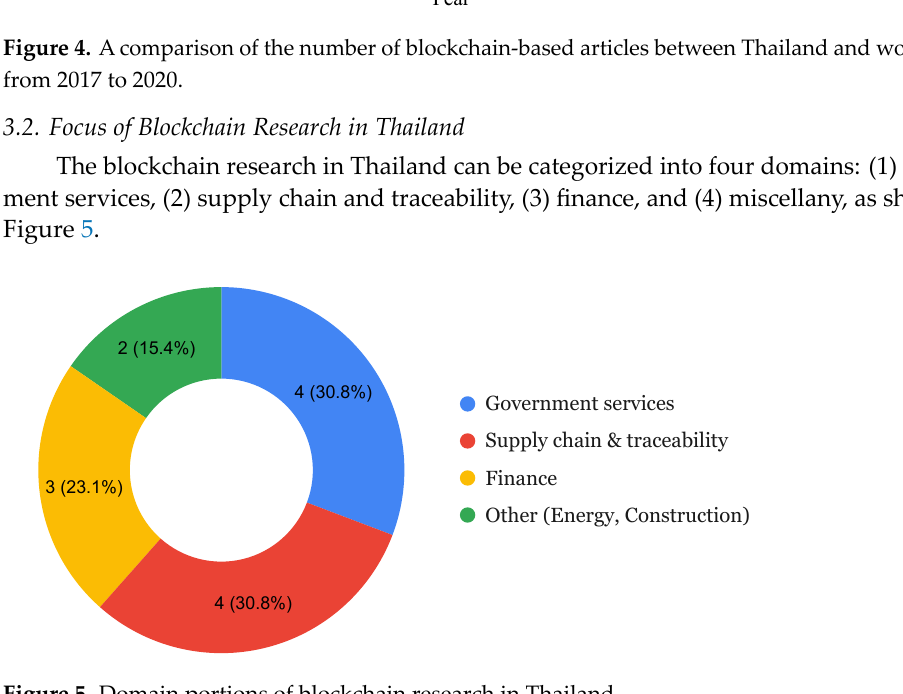
Figure 5. Domain portions of blockchain research in